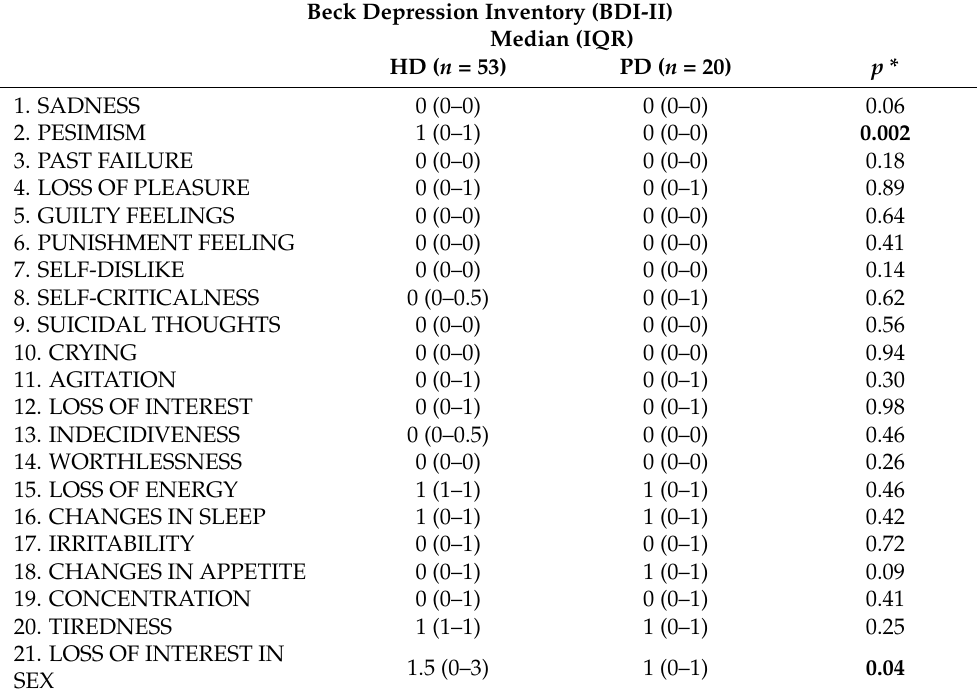
Table 4. Differences between depressive symptoms in HD and PD participants.